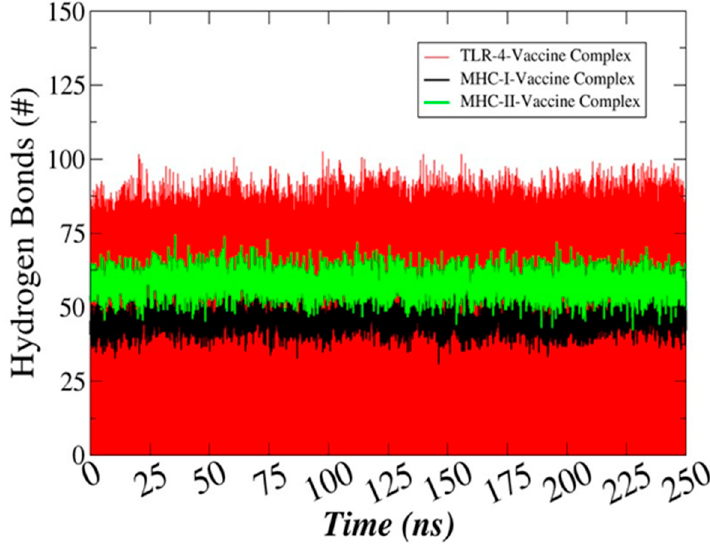
Figure 10. Number of hydrogen bonds between the vaccine construct and TLR-4, MHC-I, and MHC-II.